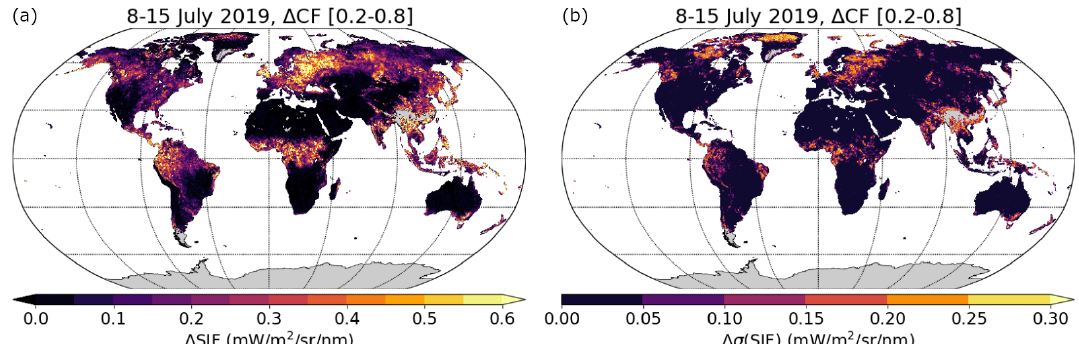
Figure 7. Differences of average SIF (a) and σ (SIF) (b) for 0.2 and 0.8 cloud fraction thresholds. Data are from the time period 8–15 July 2019 and the 743–758nm fitting